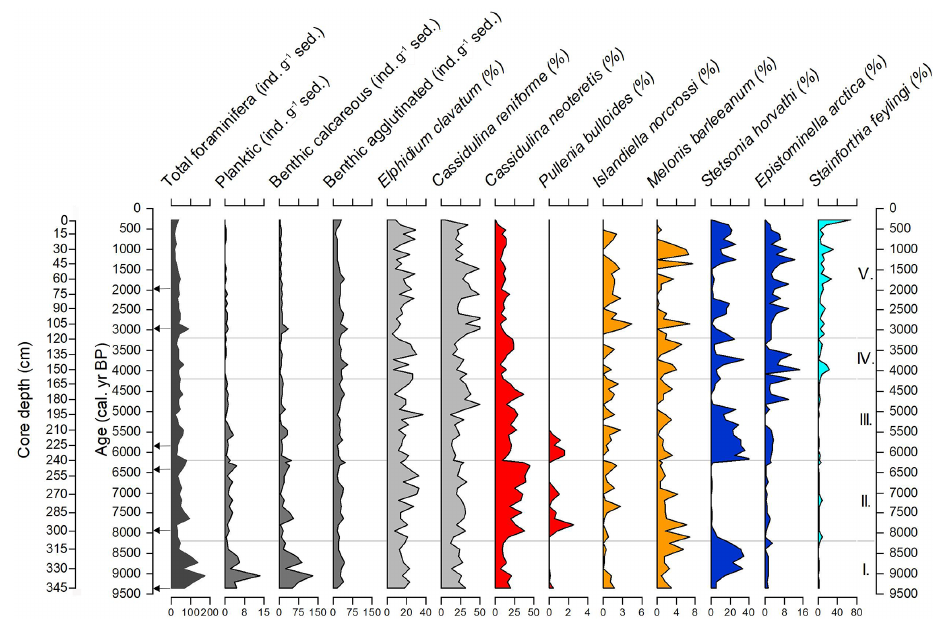
Figure A2. Foraminiferal concentrations and relative abundances of nine selected calcareous benthic species (expressed as a percentage of total benthic calcareous foraminiferal content) versus calibrated age along sediment core DA17-NG-ST07-73G. The depicted species were chosen in order to show changes in the environment. Red represents species that indicate warm Atlantic Water inflow, orange represents species that indicate in the Arctic recirculated chilled Atlantic Water influence, dark blue represents Arctic Water species that are commonly found in connection to Polar Water and often live beneath perennial or near-perennial sea ice, and light blue represents a species that indicates sea ice. Ecozones (I–V) are shown on the right side of the figure. Black arrows next to the left primary y axis (age) mark radiocarbon dates. Note that the x axes have different scalings.